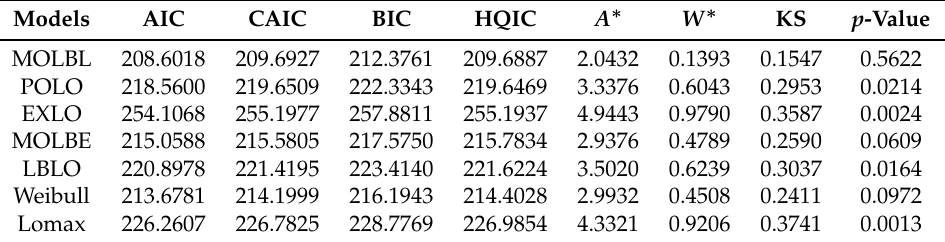
Table 14. Some criteria and goodness of fit measures for Data set 4.